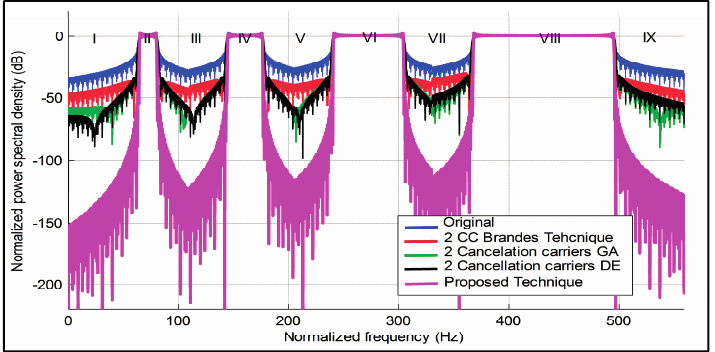
Figure 9. The PSD comparison between the proposed technique and existing techniques including CC (Brandes), CC (GA), and CC (DE).